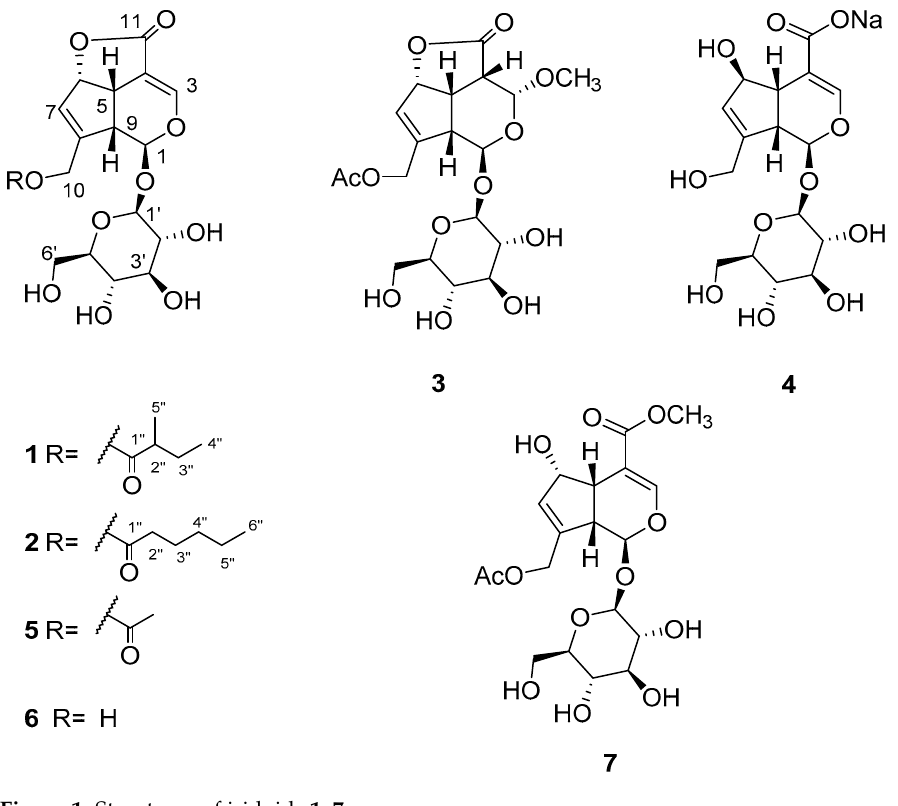
Figure 1. Structures of iridoids 1 – 7 .